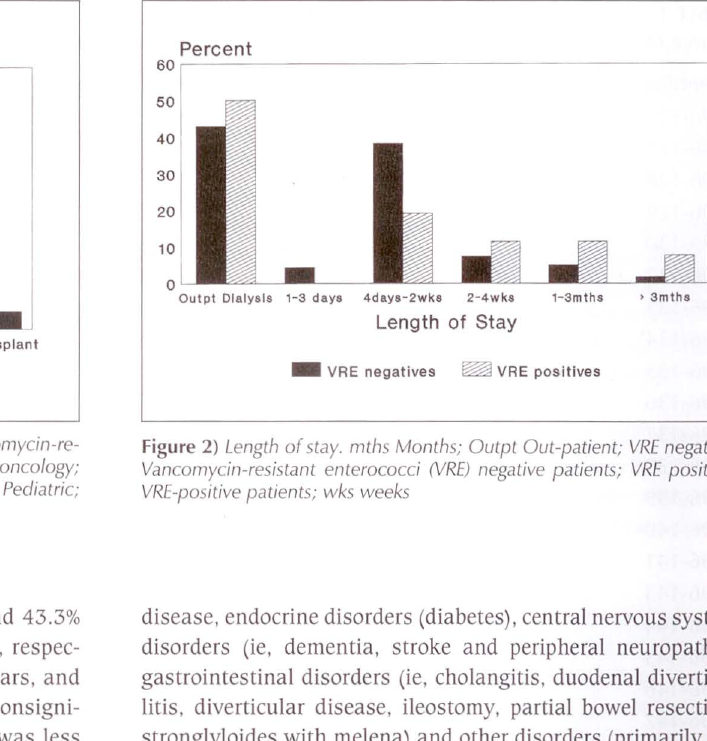
Figure 2) Length of stay. mths Months; Outpt Out-patient; VRE negatives Vancomycin-resistant enterococci (VRE) negative patients; VRE